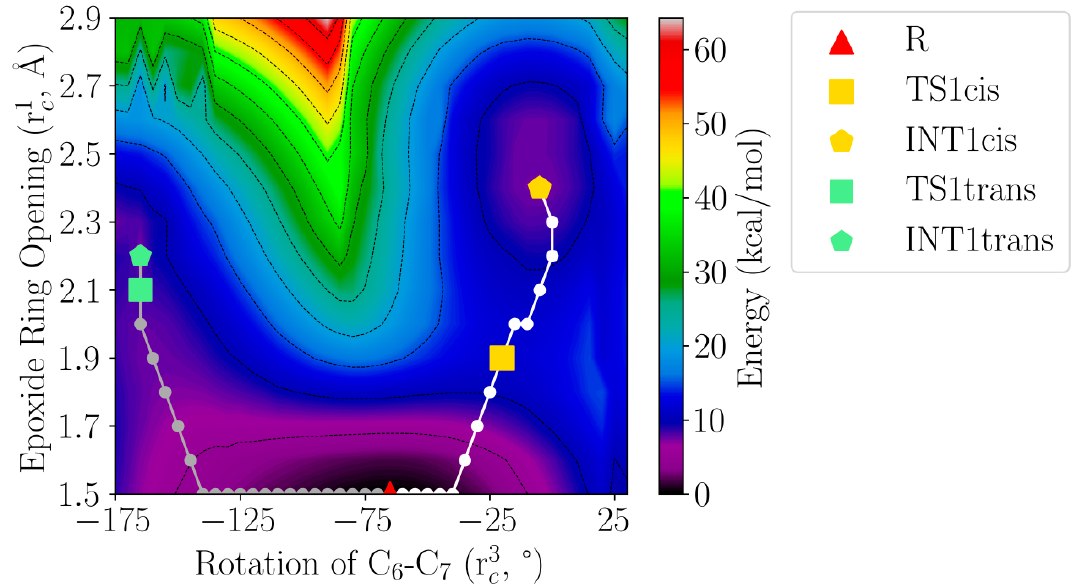
Figure 10. Two-dimensional potential energy surface as a function of the rotation of the C 6 -C 7 bond and the epoxide ring-opening reaction coordinates defined in the text. Isoenergetic lines correspond to intervals of 5 kcal/mol.